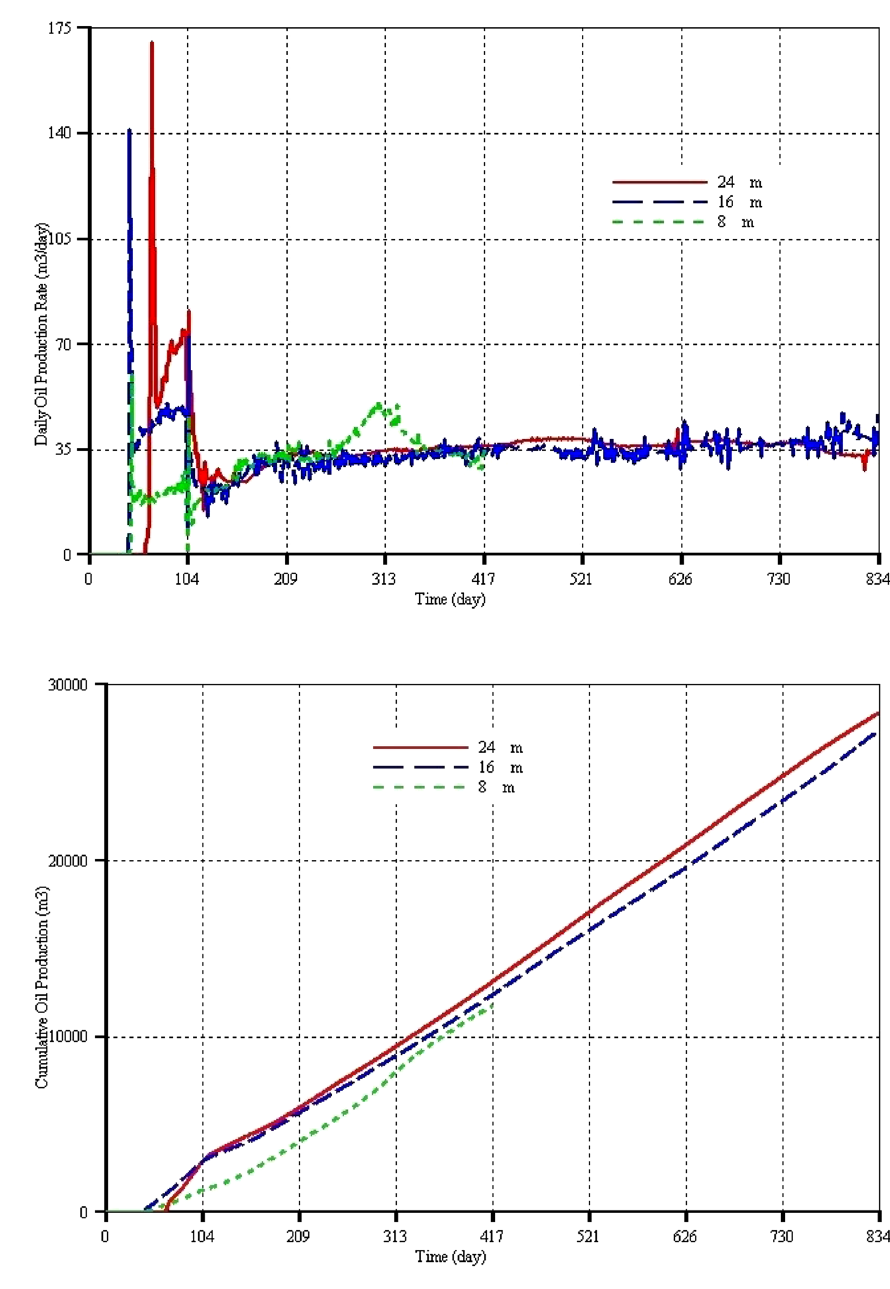
Fig. 2 Oil production rate for the different reservoir thick- nesses at constant air injection rate